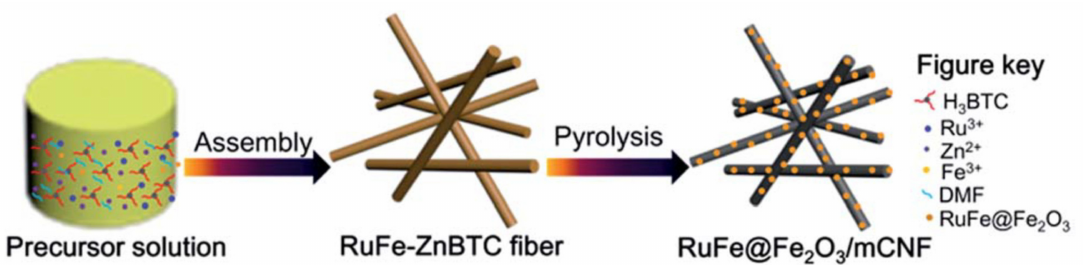
Figure 17. Schematic showing the Ru–Fe alloy mediated α -Fe 2 O 3 particles on mesoporous